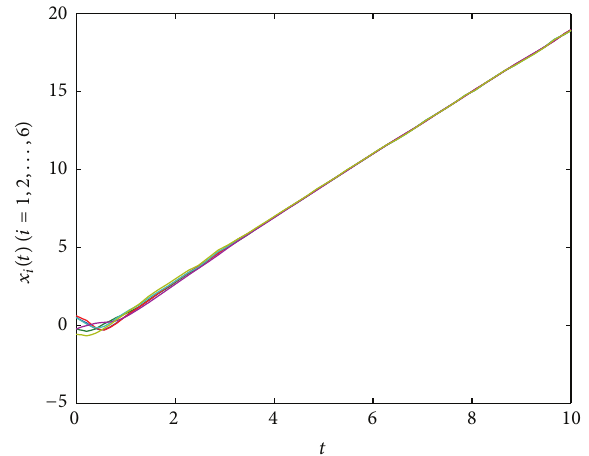
Figure 8: The position curves 𝑥 𝑖 (𝑡) (𝑖 = 1, 2, . . . , 6) for nonlinear multiagent systems (45) with 𝜏 0 = 0 , 𝜏 1 = 0.2 , 𝜏 2 = 0.3 , 𝛽 1 = 0.1 , and = 0.9 . 𝛽 2